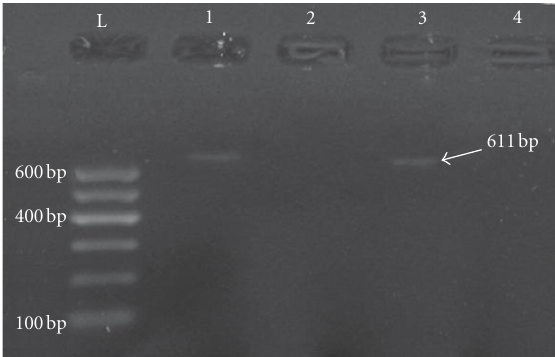
Figure 3: Detection of PCR amplified OmtBII sequence (611 bp) in the reference aflatoxins producing strain A. parasiticus BS23. Lane L indicates the 100 base pair ladder, Lane 1 and Lane 3 represent aflatoxinogenic A. parasiticus BS23, Lane 2 represents A. flavus BS48 (a nonproducer of aflatoxins), and Lane 4 represents PCR negative control. Electrophoresis was performed on 1.5% agarose gel and run with 3voltcm − 1 .